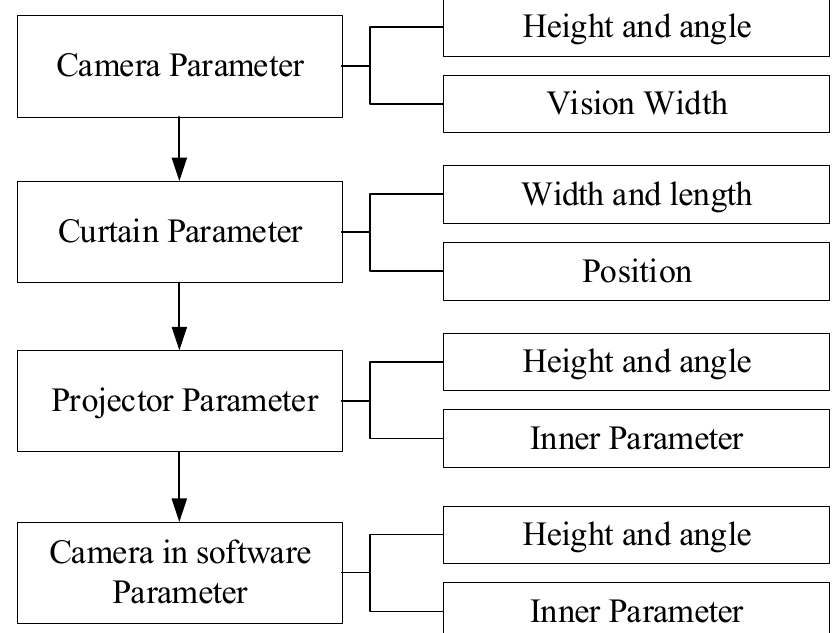
Figure 6. Projector adjustment process.